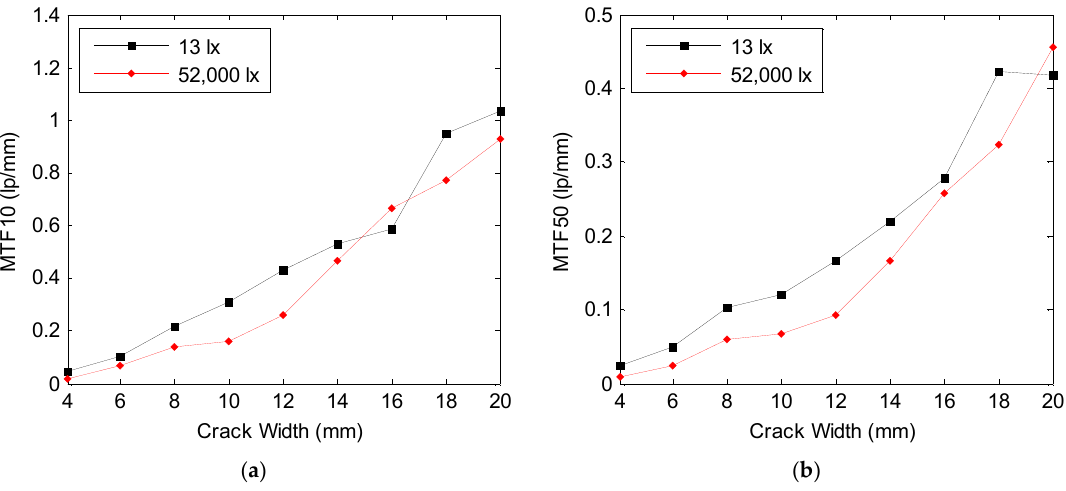
Figure 12. Comparison of ( a ) visibility shown in MTF10, and ( b ) sharpness shown in MTF50 between crack images at the 5 m object distance with the illumination of 13 lx and 52,000 lx.